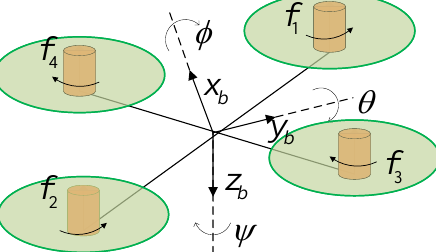
Figure 1. The body fix reference frame of the quadrotor UAV. The x b axis is set to be parallel to the body and points toward the nose. The y b axis is set to be perpendicular to the body and points to the right. The z b axis is set to be perpendicular to the x b – y b plane and pointing